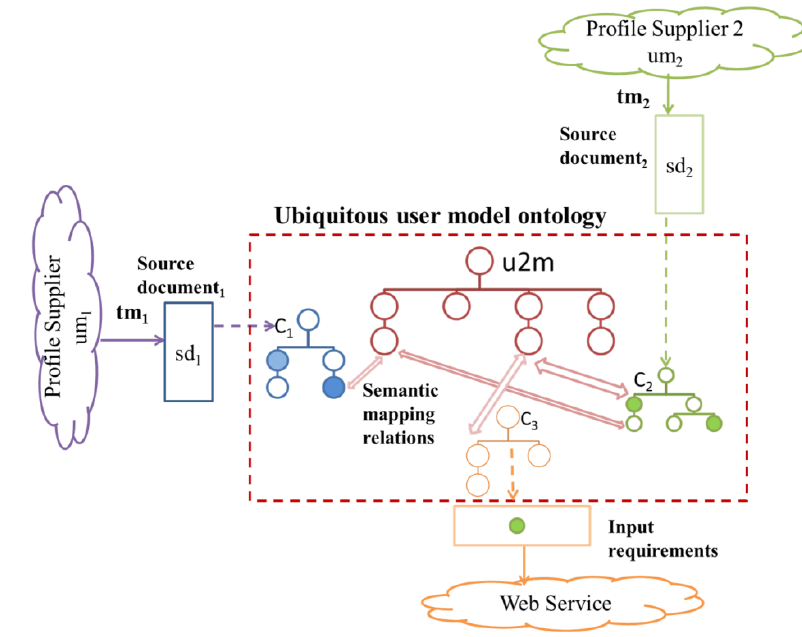
Figure 4. Interrelations between profile supplier/consumer and the ubiquitous user modeling